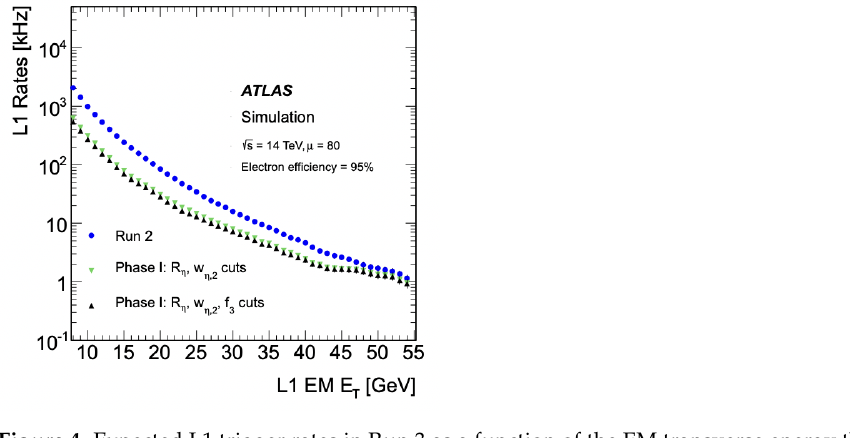
Figure 4. Expected L1 trigger rates in Run 3 as a function of the EM transverse energy threshold ( E T ) for the case of the Run 2 trigger electronics (blue) and the new upgraded digital trigger electronics with different selections of shower shape variables (black and green)